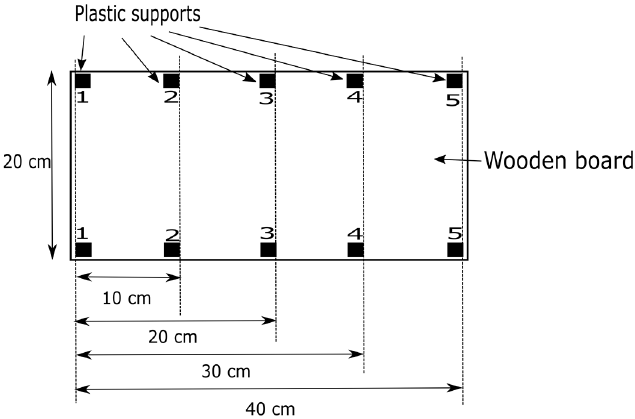
Figure 13. RIP noise characterizing test by simulating four chest sizes (60 cm, 80 cm, 100 cm, 120